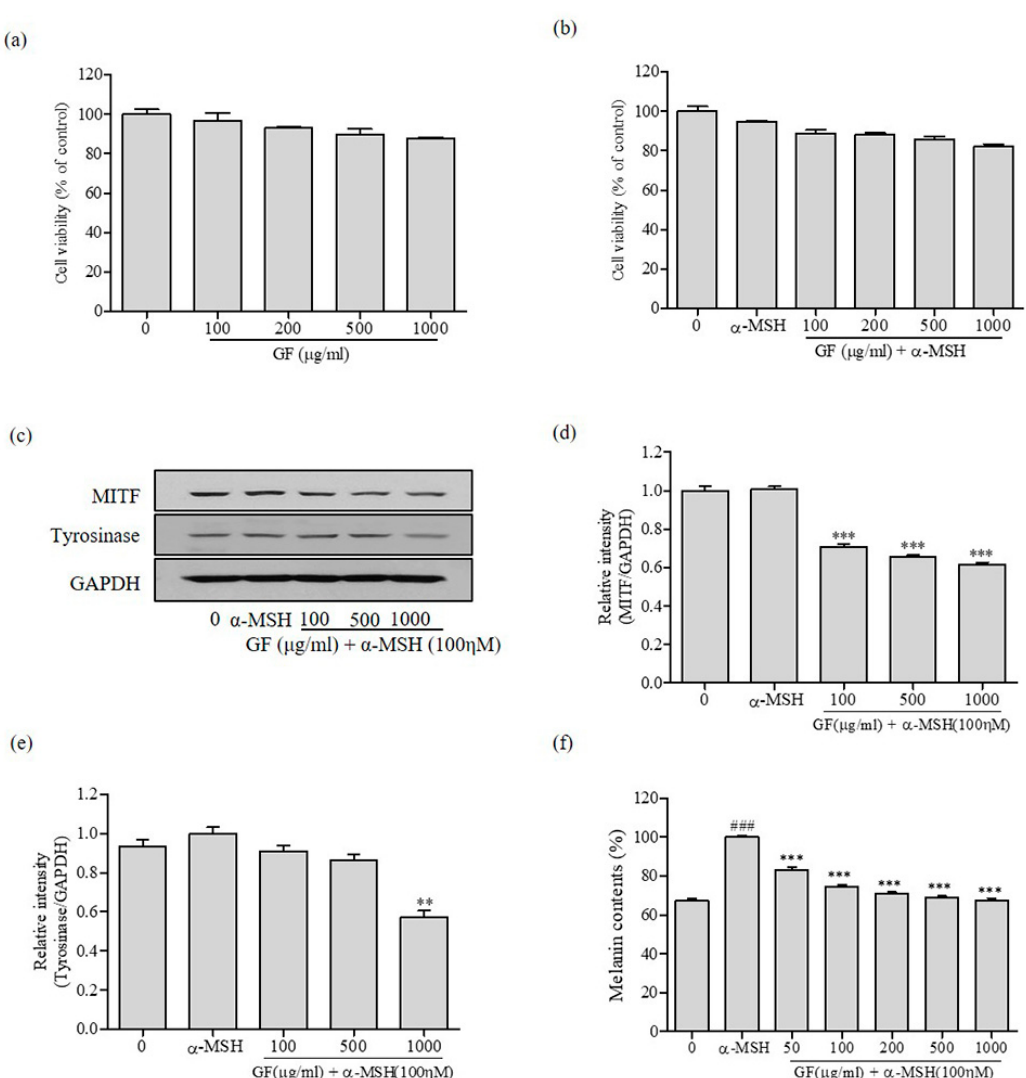
Figure 2. GF inhibited melanin production in mouse melanocyte B16F10 cells. B16F10 cells were treated with various concentrations of GF (100, 200, 500, and 1000 µ g / ml) for 24 h after vehicle ( a ) or α -melanocyte stimulating hormone ( α -MSH) (100 η M) ( b ) pretreatment for 1 h. After treatment, cell viability was measured using a WST-1 assay. ( c ) Tyrosinase and microphthalmia-associated transcription (MITF) from cell lysates were determined by immunoblotting analysis. ( d , e ) The bar graphs represent the quantitation of tyrosinase and MITF blotting data. The absorbance was measured by an ImageJ. GAPDH was used as an internal control. ( f ) Melanin content assay of the GF on the B16F10 cells. The absorbance was measured at 420 nm by an ELISA. Data are presented as mean ± SEM. ### p < 0.001 compared to nonstimulated cells (GF 0 µ g / ml). ** p < 0.01 and *** p < 0.001 compared to α -MSH-stimulated cells.